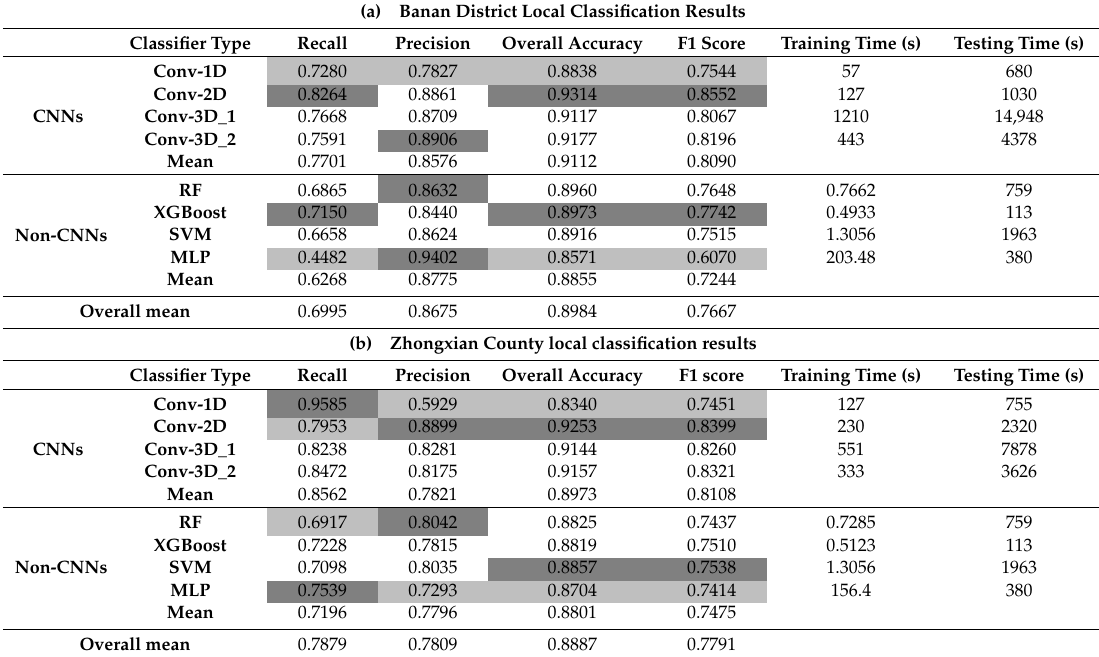
Table 4. Classifiers local accuracy evaluation in Banan District ( a ) and Zhongxian County ( b ); Boxes with black and grey colors represent the maximum and minimum values of the evaluation indicators of CNNs or non-CNNs,